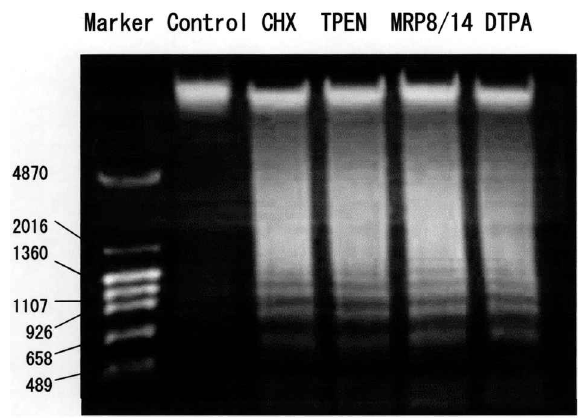
FIG. 5. Agarose gel electrophoresis of DNA extracted from EL-4 cells. Cells were cultured in standard medium without or with rhMRP8/rhMRP14 complex (5 m M) on DTPA (20 m M) for 24h, or with TPEN (10 m M) or cycloheximide (CHX) (200 m g/ml) for 6h. DNA was extracted and electrophoresed as described in Materials and methods.